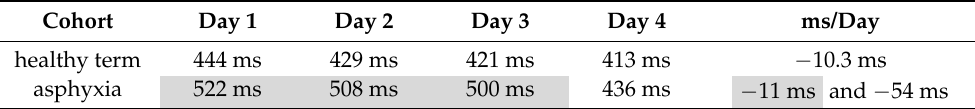
Table 1. Median QTCc values and the decrease in ms/day (for the healthy term, over 4 days ( − 10.3 ms/day) for the asphyxia cases over 3 days during therapeutic hypothermia ( − 11 ms/day), or between day 3 and day 4, from therapeutic hypothermia to normothermia, − 54 ms) as reported in healthy term or asphyxia cases. Observations collected during hypothermia were highlighted in grey, data from